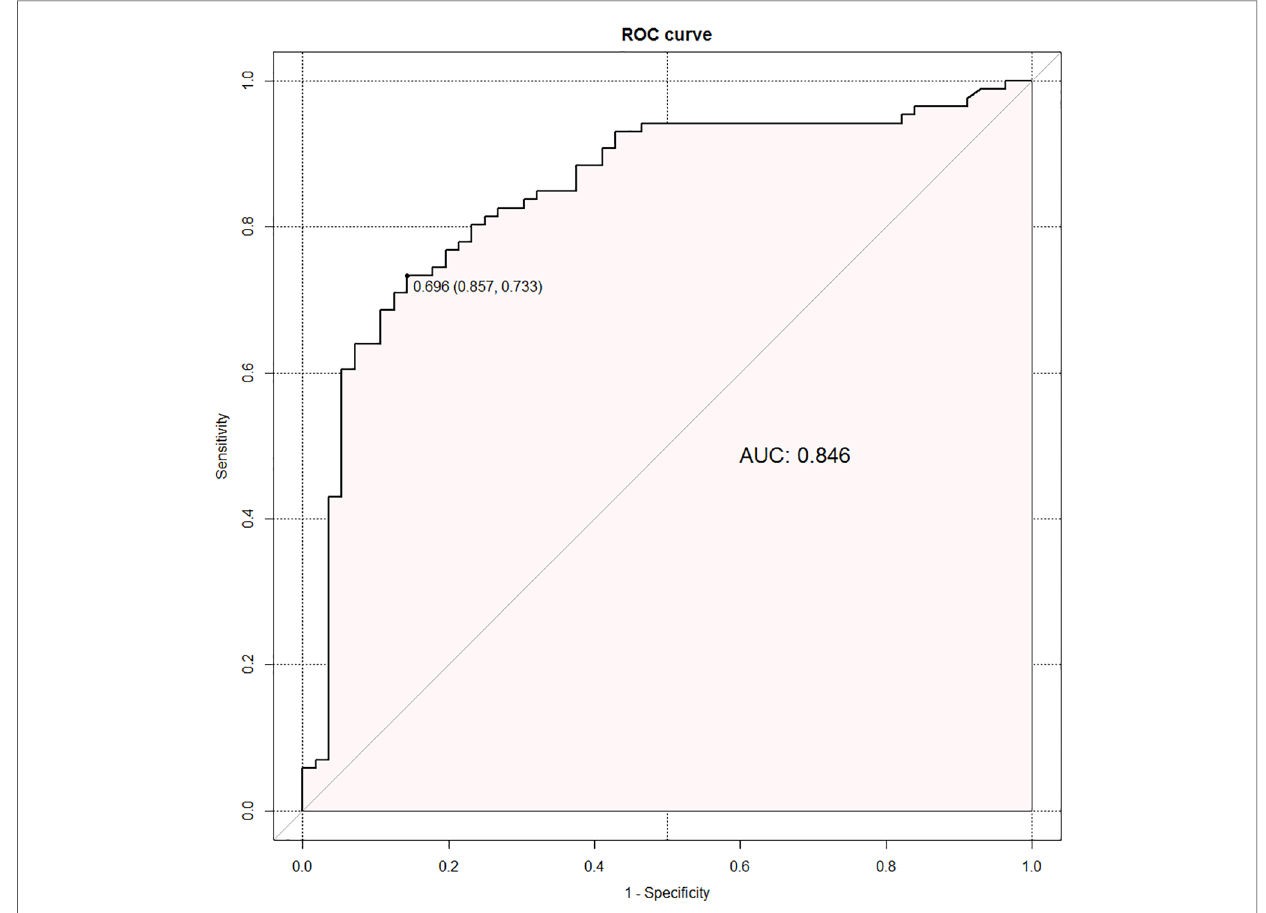
FIGURE 3 Receiver operating characteristic curve of the regression